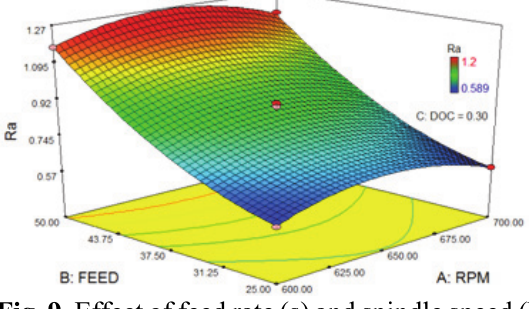
Fig. 9. Effect of feed rate (s) and spindle speed (N) on surface roughness (3-D plot)